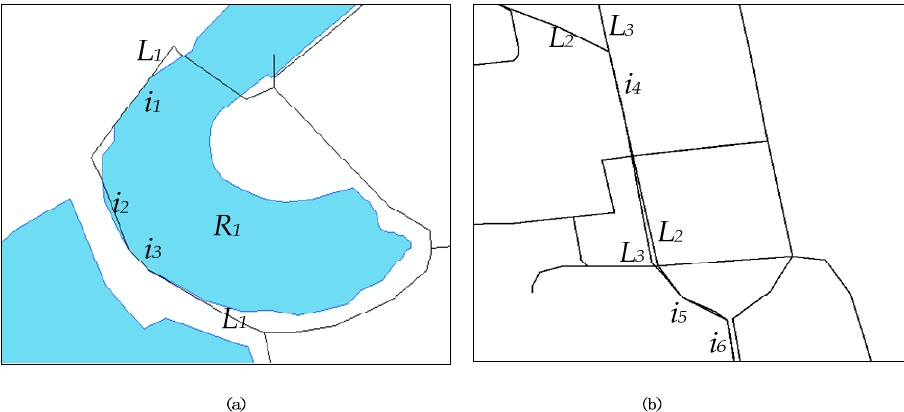
Figure 1. Examples of multiple intersection components between line/region and line/line in OpenStreetMap (OSM) data. ( a ) A lake has multiple intersection components with the same trajectory; ( b ) One trajectory multiple intersection components with another trajectory.